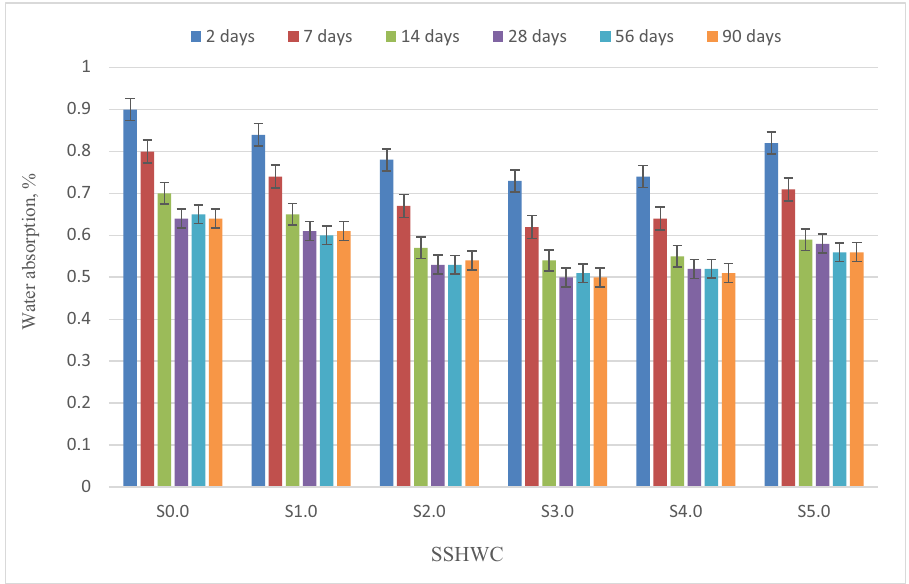
Figure 11: Water absorption of SSHWC